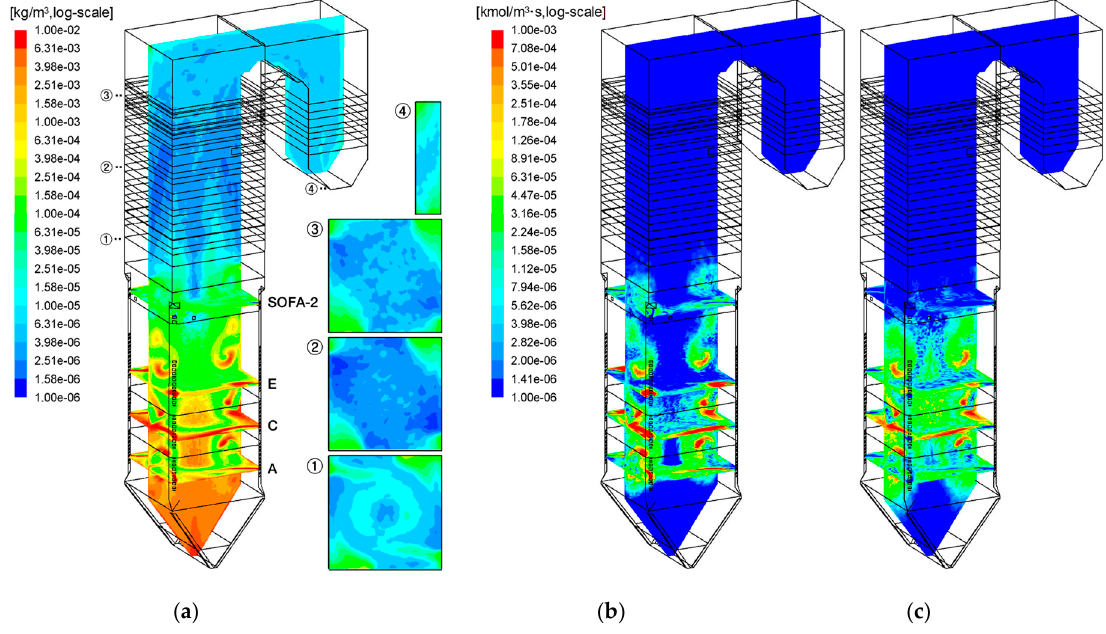
Figure 4. Solid carbon concentration and char conversion rates for the reference (C05-S20). ( a ) Solid carbon concentration; ( b ) Char-O 2 rate and ( c ) Char-CO 2 rate.